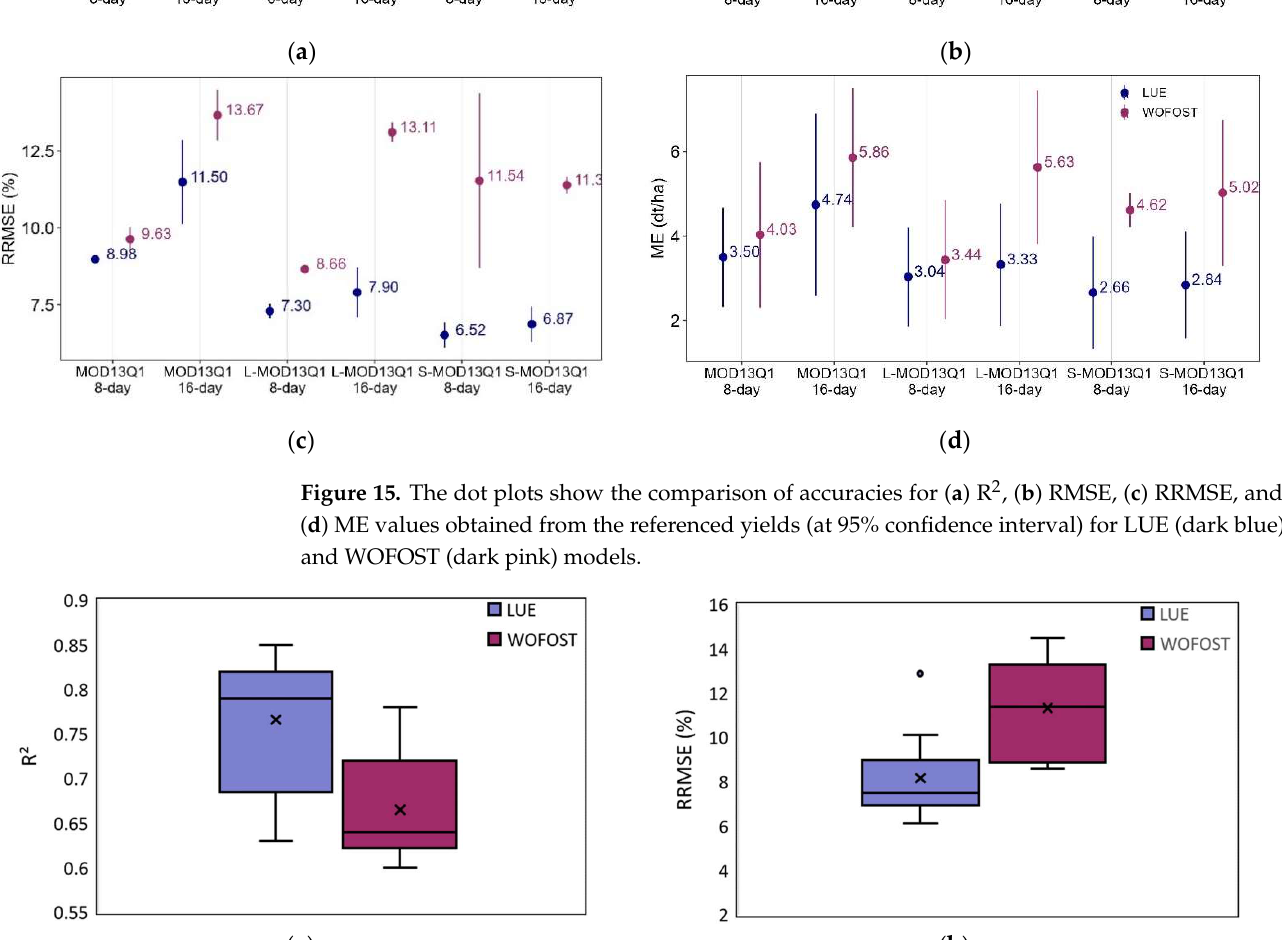
Figure 16. The box plots compare the accuracies for ( a ) R 2 and ( b ) RRMSE of referenced (at 95% confidence interval) and modelled yields obtained from multi-source data using LUE and WOFOST models in 2019.